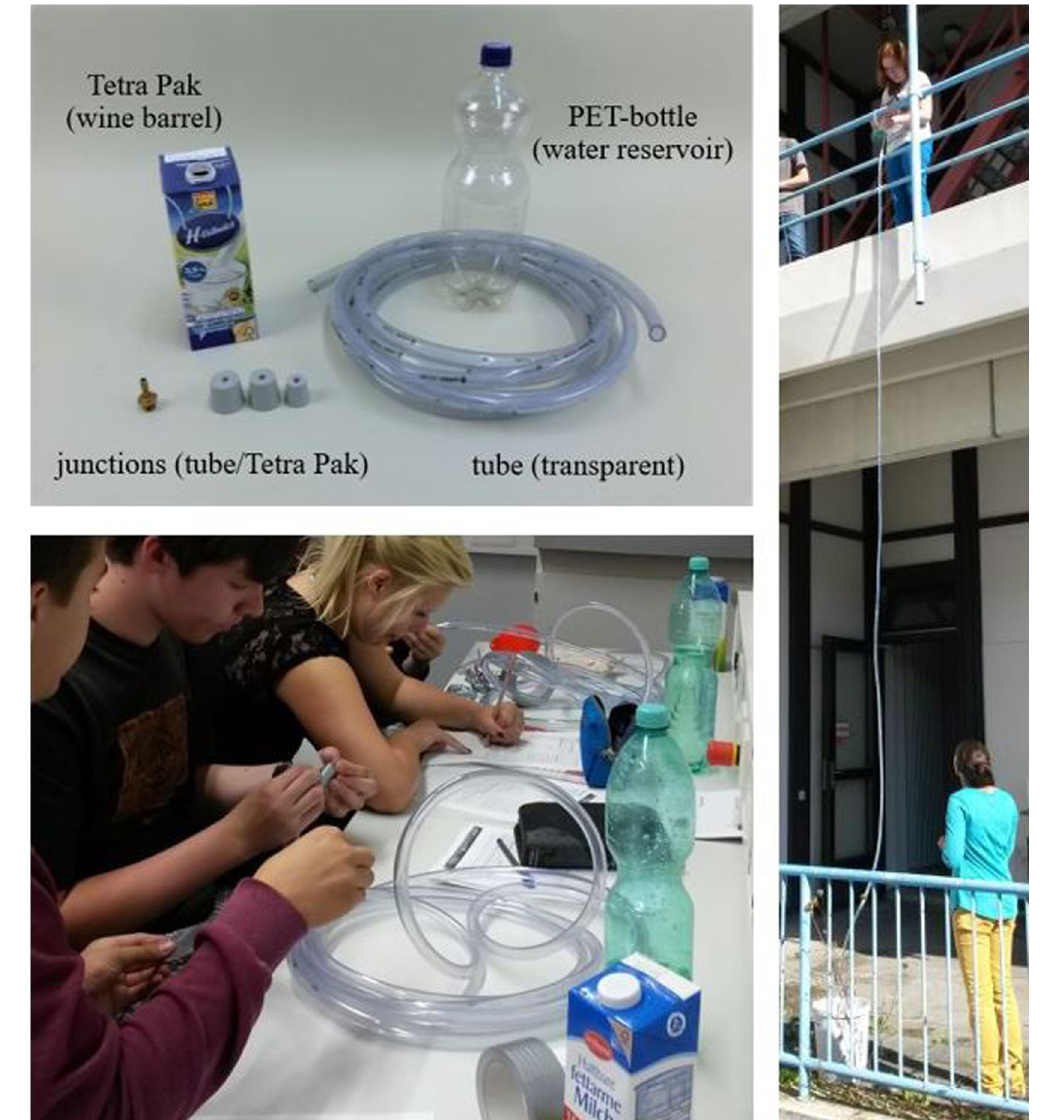
FIG. 4. Hands-on experiment on the bursting of a wine barrel according to Blaise Pascal [122]. Because of the necessary height difference (several meters), part of the activity was carried out outside the